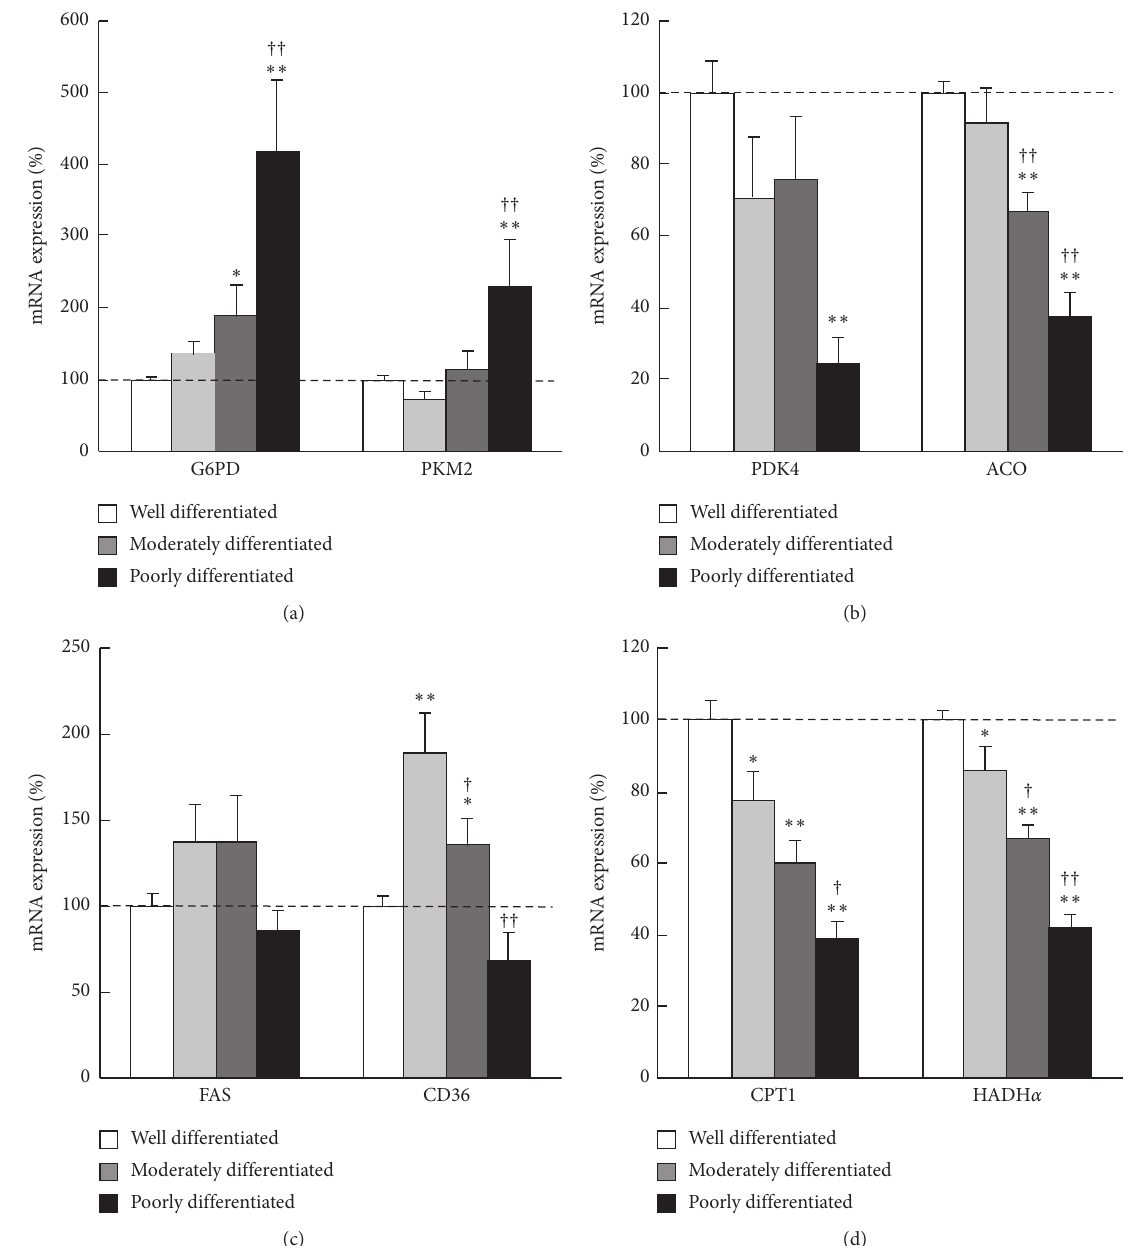
Figure 4: Metabolic gene expression levels in each degree of cancer differentiation in human HCC samples. Quantitative RT-PCR analysis of metabolic genes related to (a) glycolysis, (b) TCA cycle, (c) FA synthesis and uptake, and (d) β -oxidation. The gene expression levels normalized to those of noncancer tissues and were presented as mean ± SE. ∗ p < 0 . 05 and ∗ ∗ p < 0 . 01 vs. noncancer tissue. † p < 0 . 05, †† p < 0 . 01 vs. well-differentiated HCC tissue. G6PD, glucose-6-phosphate dehydrogenase; PK, pyruvate kinase; PDK, pyruvate dehy- drogenase kinase; ACO, aconitase; FAS, fatty acid synthase; CPT, carnitine palmitoyltransferase; HADH, hydroxyacyl-coenzyme A